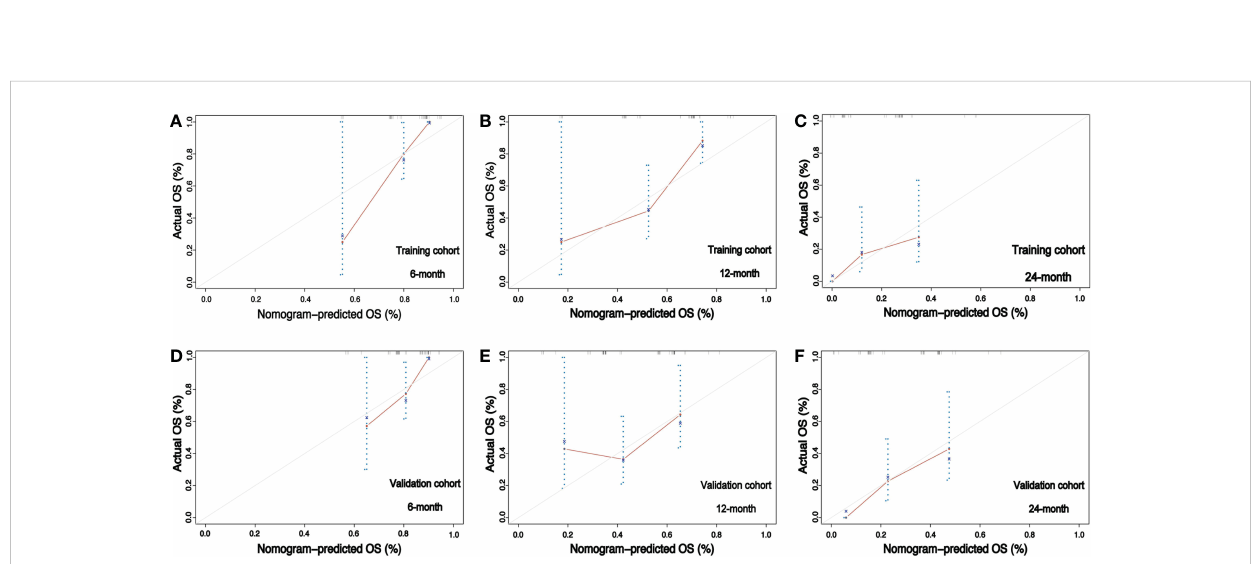
FIGURE 6 Calibration curves for the training and validation cohorts. (A – C) Calibration plots comparing nomogram-predicted and observed overall survival in the training cohort at 6, 12, and 24 months, respectively. (D – F) Calibration plots comparing nomogram-predicted and observed overall survival in the validation cohort at 6, 12, and 24 months, respectively.